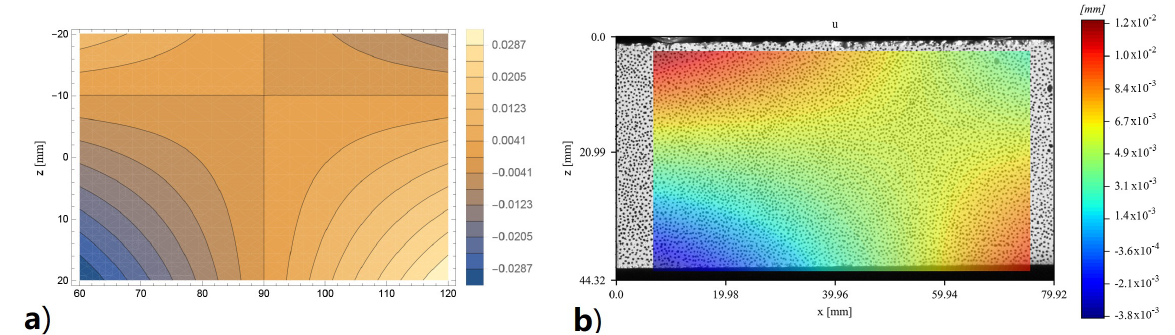
Figure 12. Contour of horizontal displacements of 4PB-DIC-LP_02 sample: ( a ) prevision obtained by the bi-modulus model ( b ) results obtained by DIC